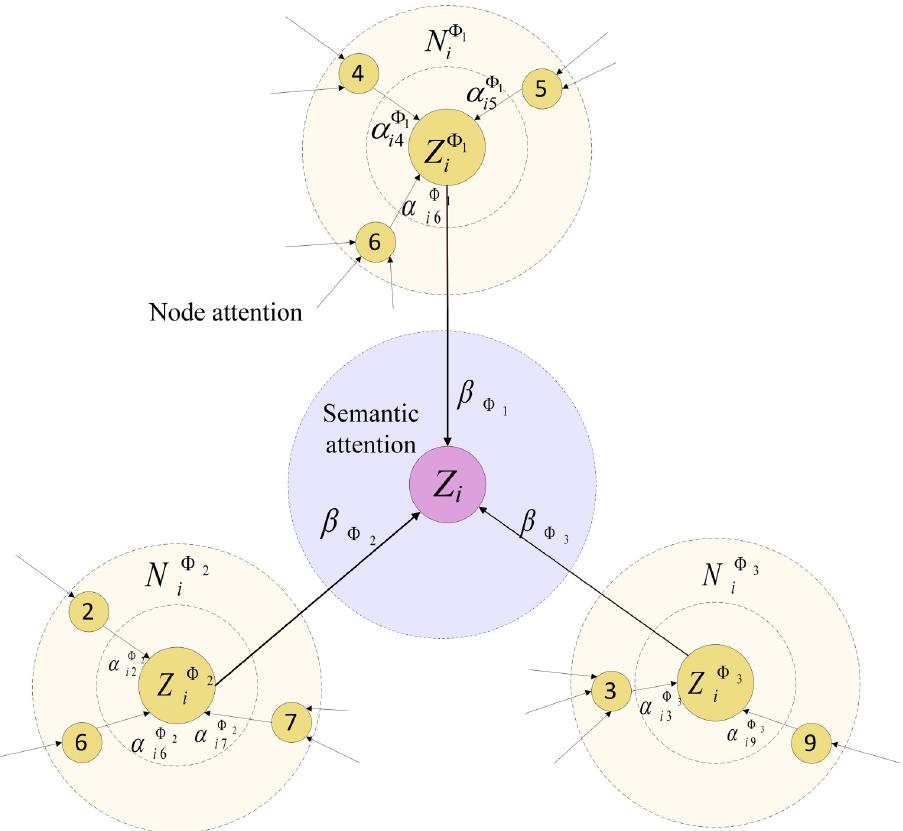
Fig 3. The hierarchical attention mechanism of the MHAN model. Nodes 4–6 are neighbors of node i based on meta-path Ф 1 ; nodes 2, 6, and 7 are neighbors of node i based on meta-path Ф 2 ; nodes 3 and 9 are neighbors of node i based on meta-path Ф 3 . After the aggregation on each meta-path, embeddings with different semantics are fused to . obtain the final representation of node i , which is denoted as Z i